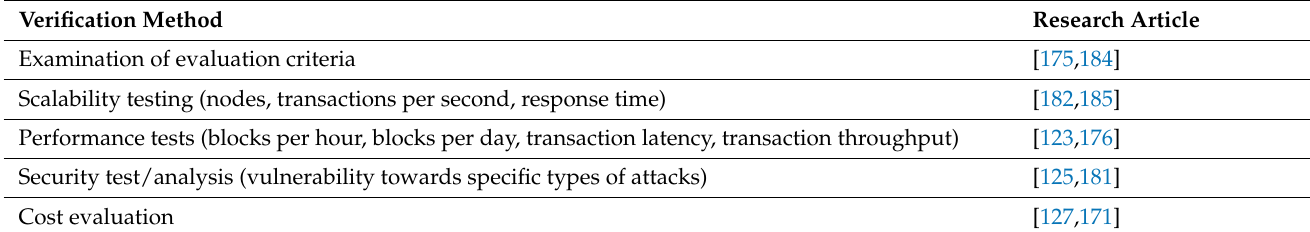
Table 10. The methods of verification employed in the chosen